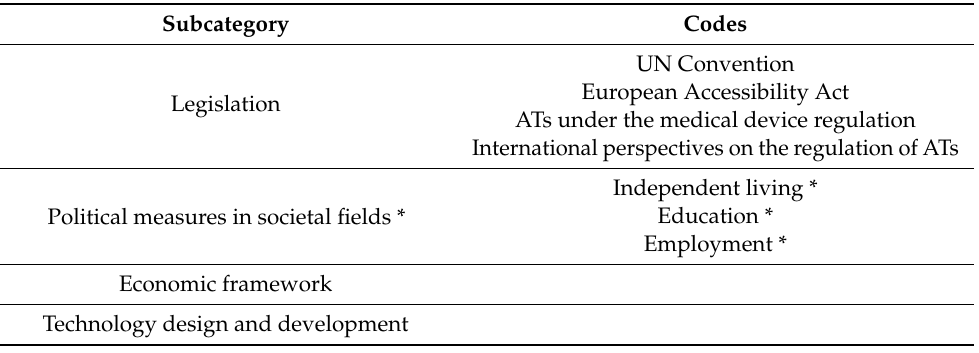
Table A4. Set II—Complementary Measures by the Public